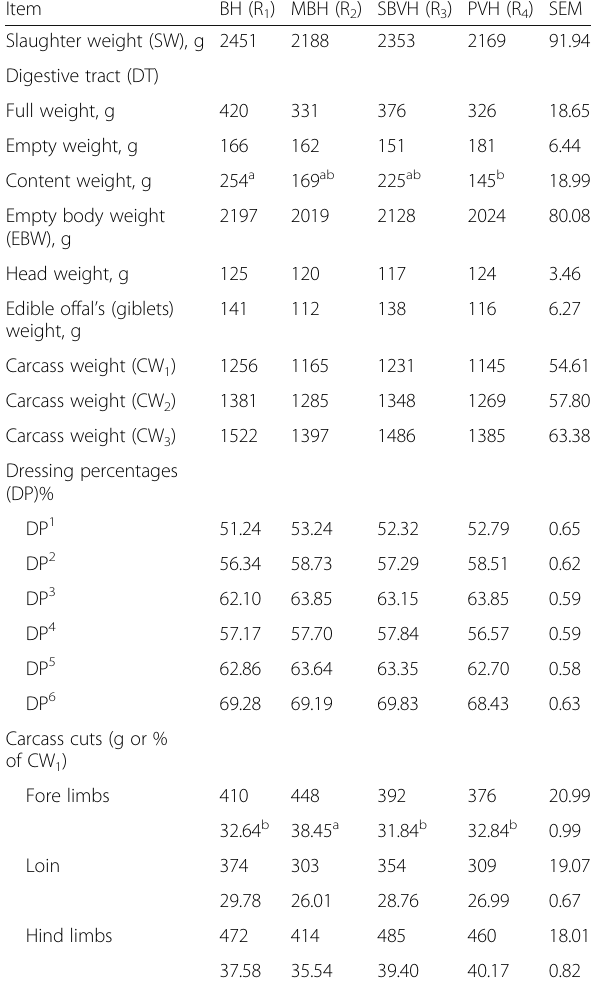
Table 5 Dressing percentages and carcass cuts of the experimental